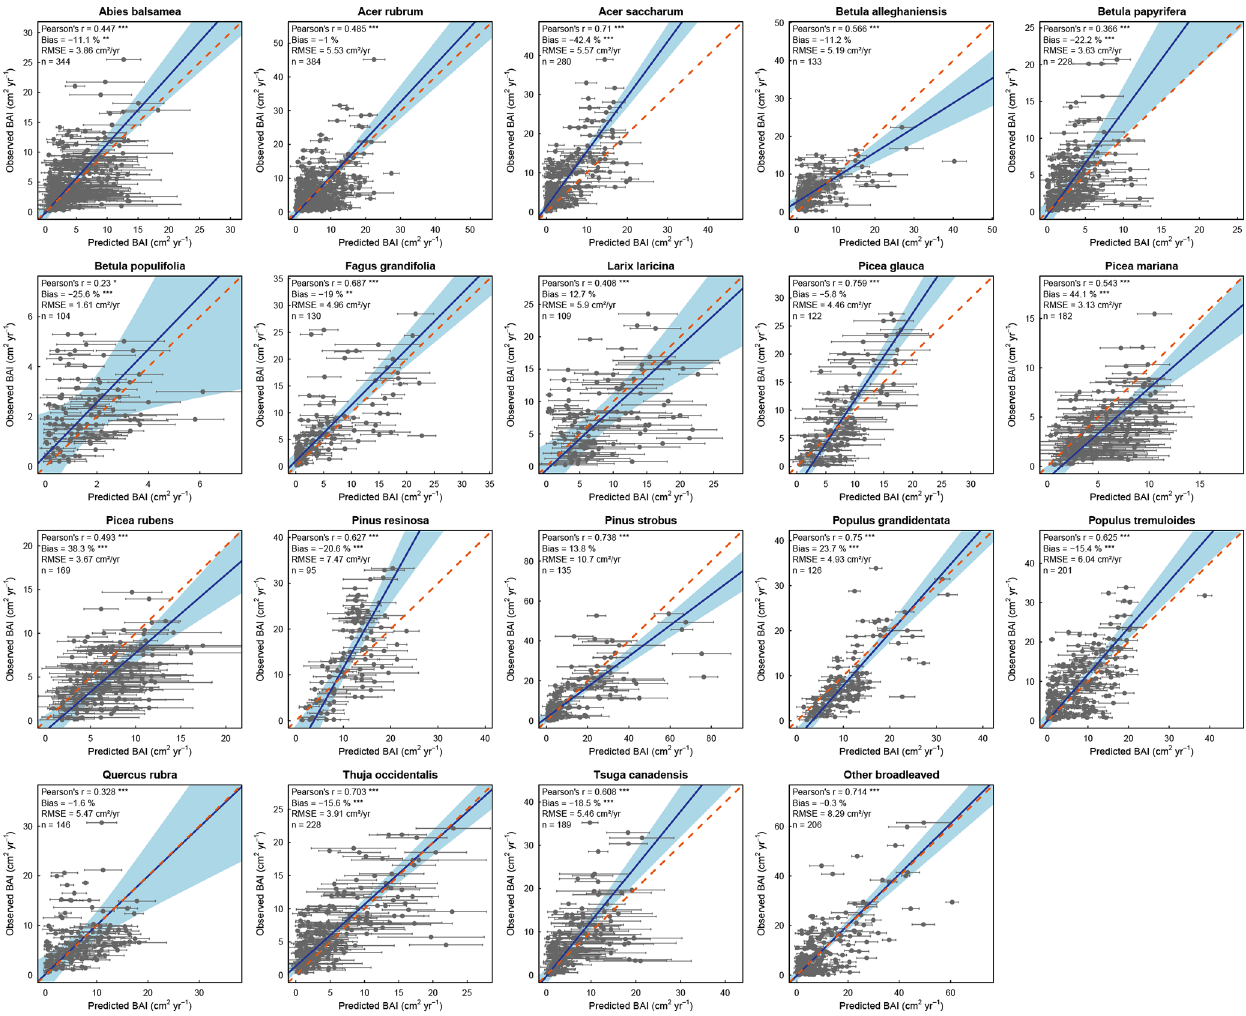
Figure 2. Observed versus mean predicted basal area increment for each species (or group of species) using the evaluation dataset. Each dot represents the mean of the 10 predictions for a single tree, with the error bars indicating the standard deviation. The blue line represents the Deming regression between observed and predicted values, the light-blue area is the confidence interval at 95%, and the dashed red line corresponds to the 1 : 1 line. Model performance is indicated using Pearson’s r ( p value: ∗∗∗ < 0.001; ∗ < 0.05), the relative bias (paired